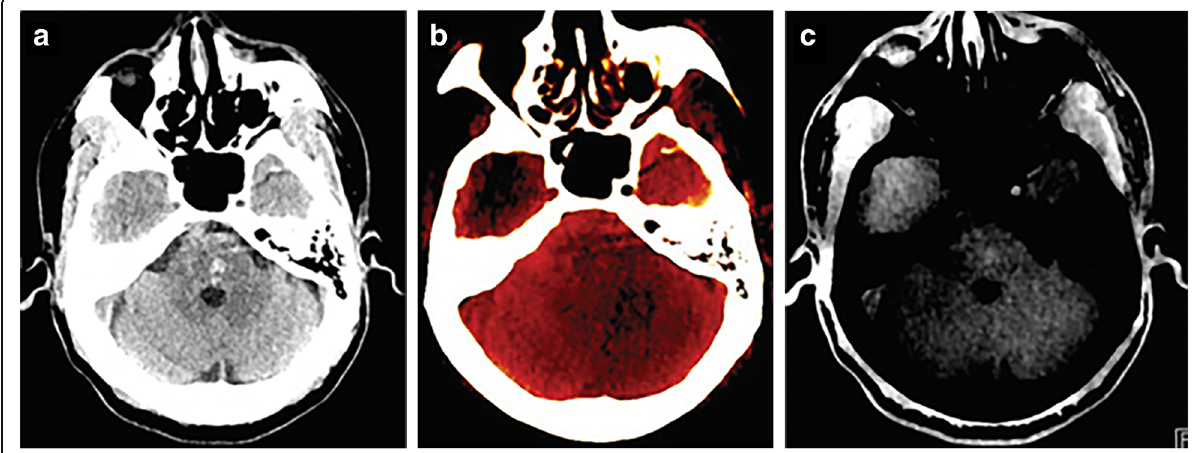
Fig. 2 Head dual-energy computed tomography scan shows focal hyperattenuation in the pons, classified as indeterminate at standard grayscale series ( a ). This 58-year-old patient had a history of hypertension and diabetes and presented to the emergency department with right arm tremor, blurry vision, and increased systolic blood pressure. On the calcium-overlay image, the focal hyperattenuation in the pons was not apparent ( b ). On the virtual non-calcium image ( c ), the focal hyperattenuation in the pons manifests as a focal area of high attenuation, compatible with hemorrhage. From Hu et al.